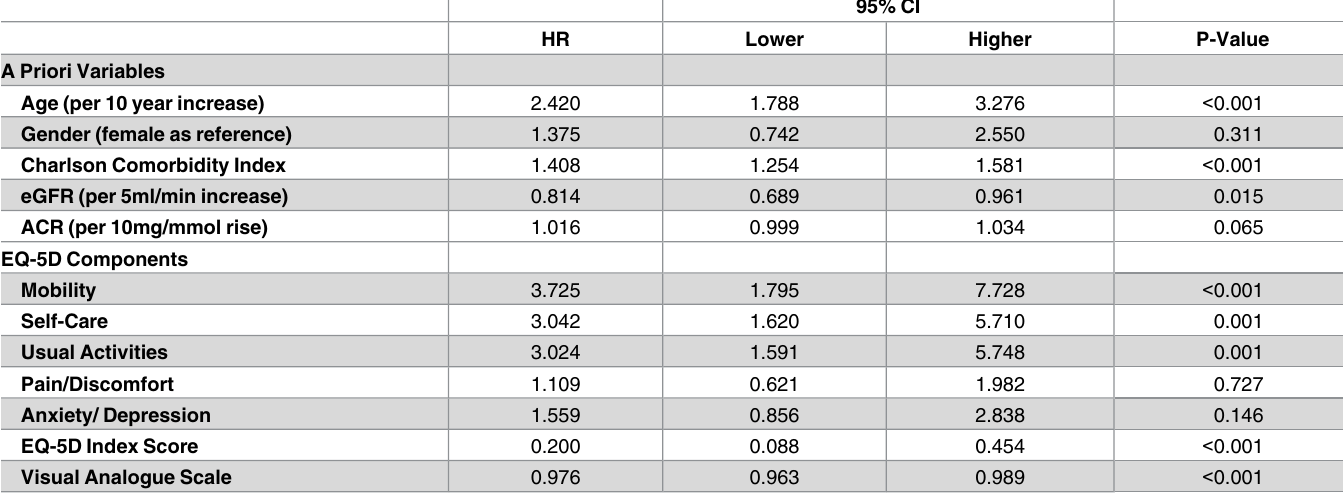
Table 4. Univariable Survival Analyses(Cox regression) for hazard ratio (HR) for death. A priori variablesand all componentsof EQ-5D